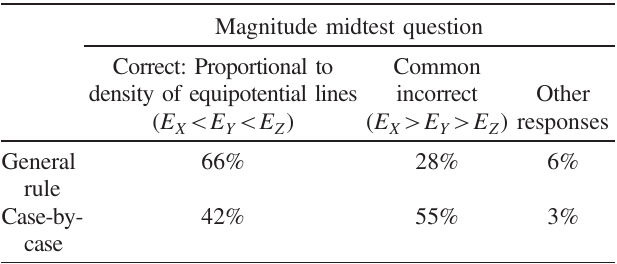
TABLE I. Student response percentages to the midtest